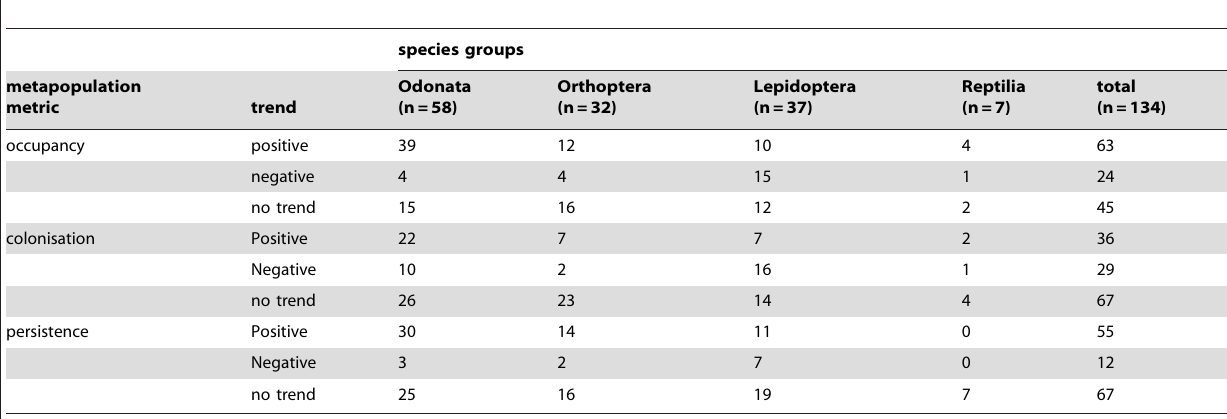
Table 1. Number of species by group showing significantly increasing trend, significantly decreasing trend or no significant trend in metapopulation metrics.